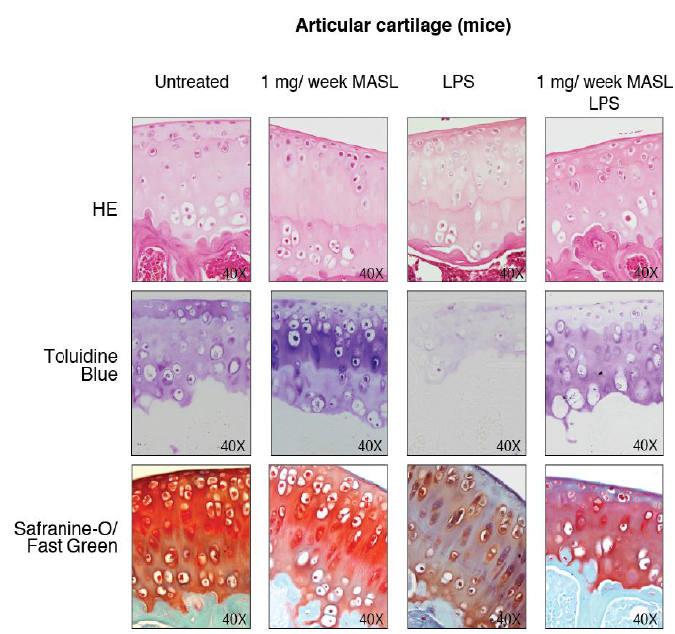
Figure A3. MASL protects articular cartilage structure in vivo in pathological conditions: animal model. Images show representative samples of haematoxylin–eosin (HE), toluidine blue, and Safranin-O Fast Green staining (see Figure 3D).